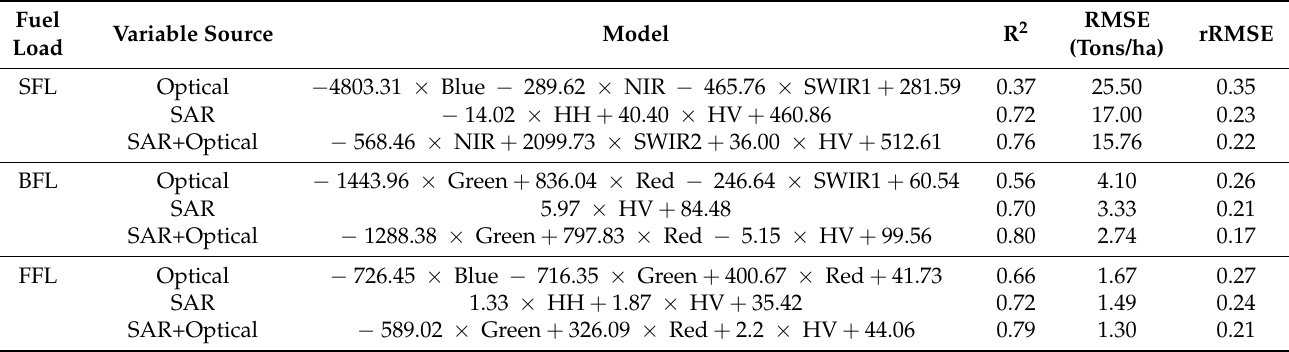
Table 4. Fuel load estimation models. RMSE: root mean square error; rRMSE: relative RMSE. Fuel Variable Load